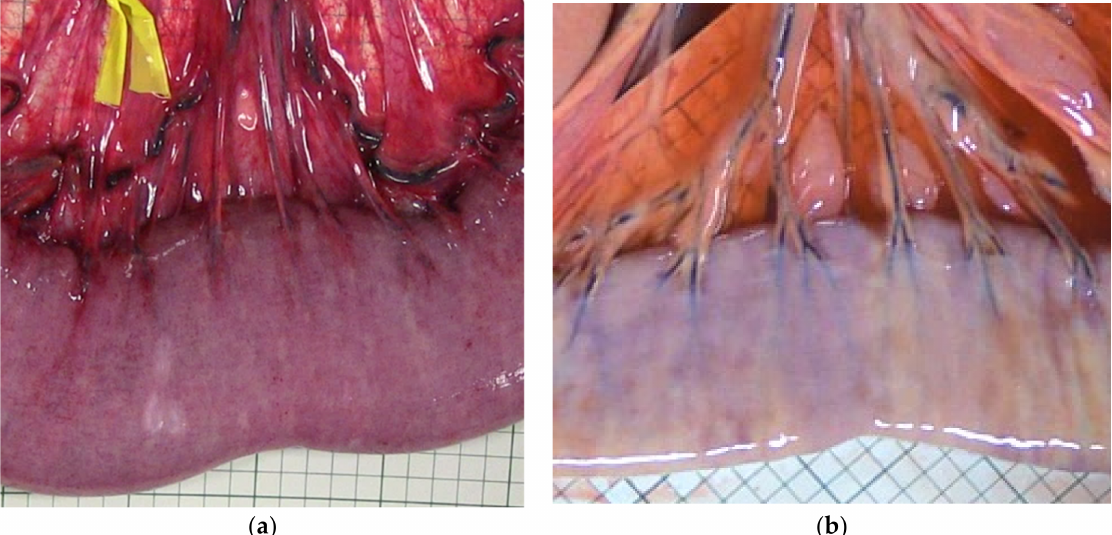
Figure 6. Clinical appearance of the jejunum after being subjected to two hours of different segmental ischaemia: low flow ischaemia ( a ) displaying intense purple discolouration, and no flow ischaemia ( b ) with mild purple discolouration and vessel-associated pale areas.